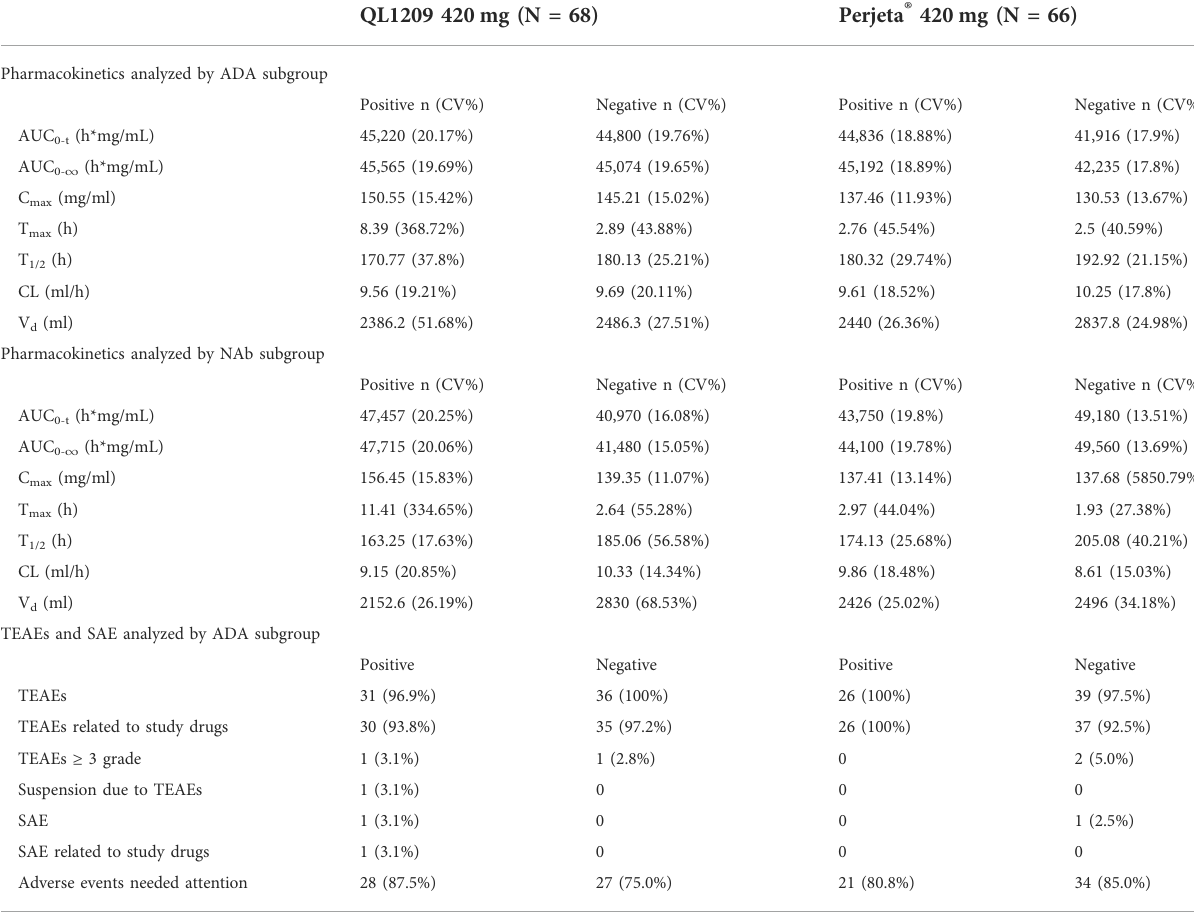
TABLE 5 Summary of pharmacokinetic parameters for QL1209 and Perjeta ® analyses by ADA and NAb subgroup. QL1209 420 mg (N = 68) Perjeta ® 420 mg (N =